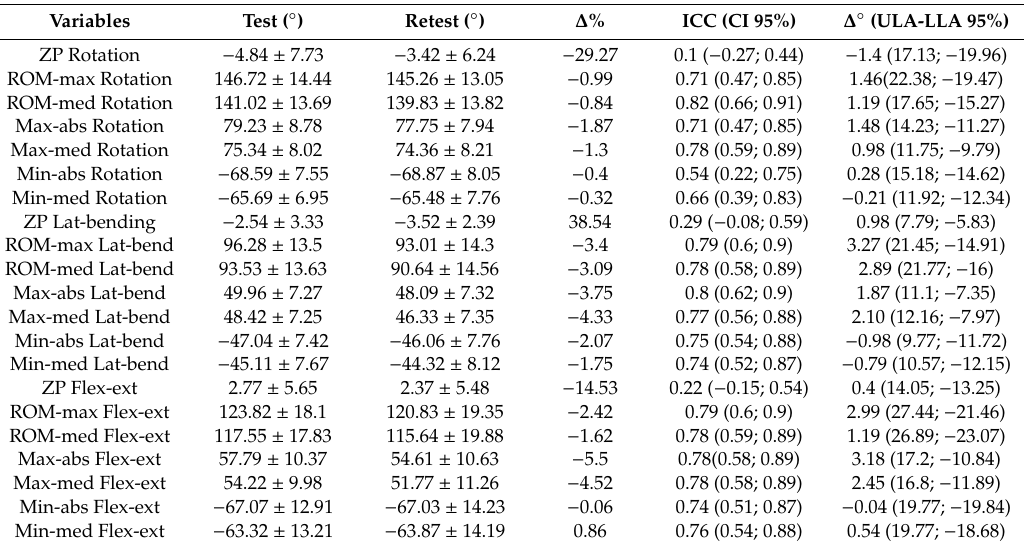
Table 2. Results for young